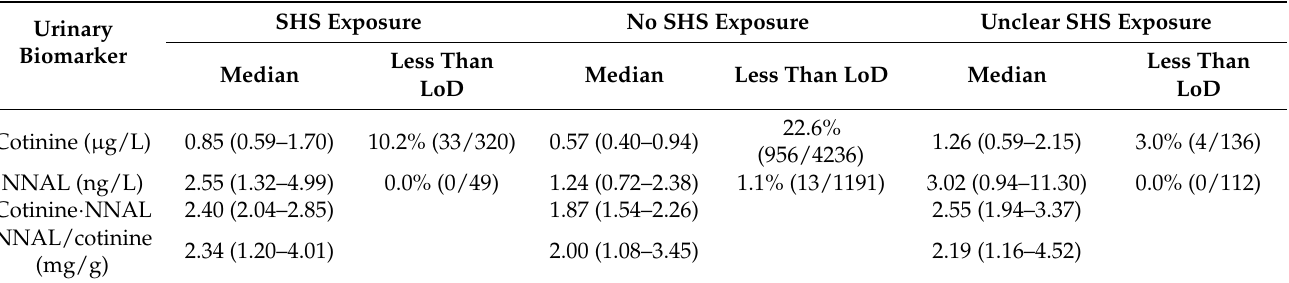
Table 4. A comparison of the diagnostic performance of four urinary biomarkers in non-current smokers, according to SHS